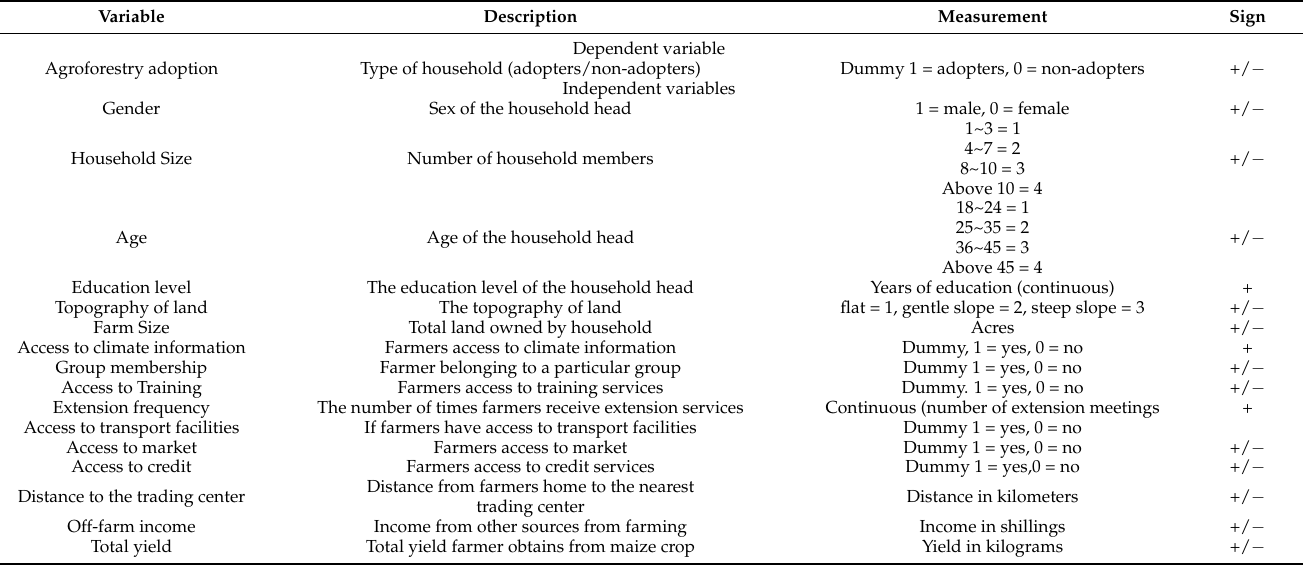
Table 1. Description of the dependent and independent variables used in the